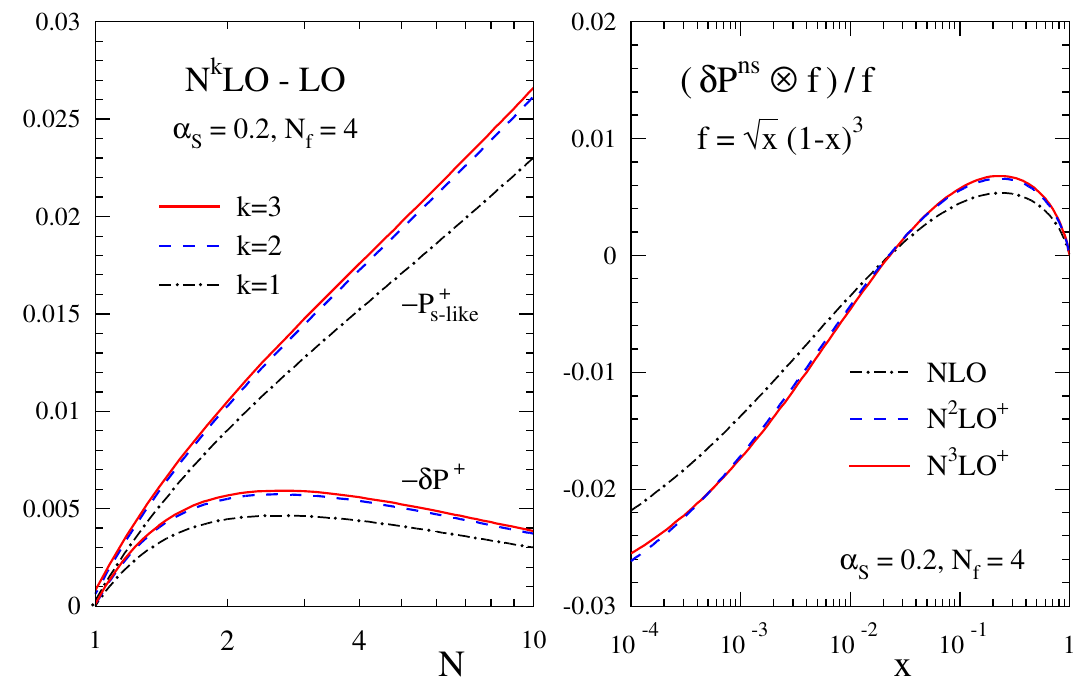
Figure 13 . The perturbative expansion of the di(cid:11)erence (cid:14) P + = P + like ( (cid:27) = 1) and space-like ( (cid:27) = compared to beyond-LO contributions in the space-like case. Right: convolution with the schematic input shape